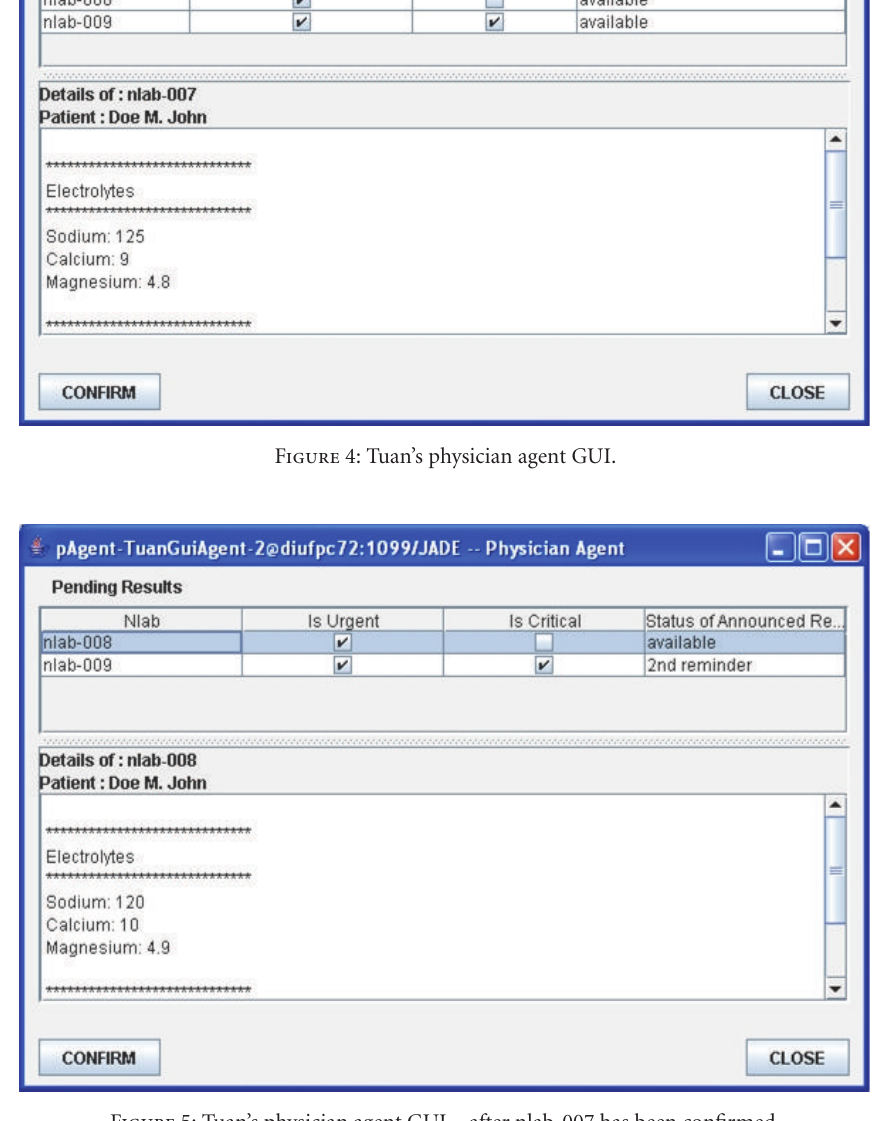
Figure 5: Tuan’s physician agent GUI—after nlab-007 has been